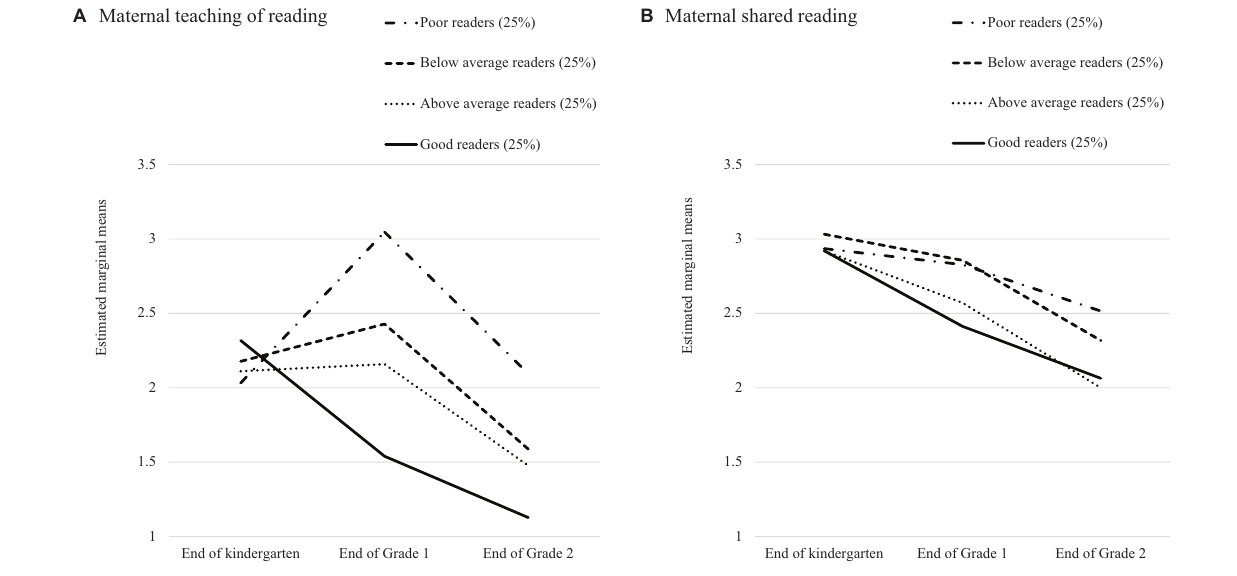
FIGURE 3 | Estimated marginal means of the frequency of maternal teaching reading (A) and shared reading (B) at three time points as a function of children’s word-reading skills at the end of Grade